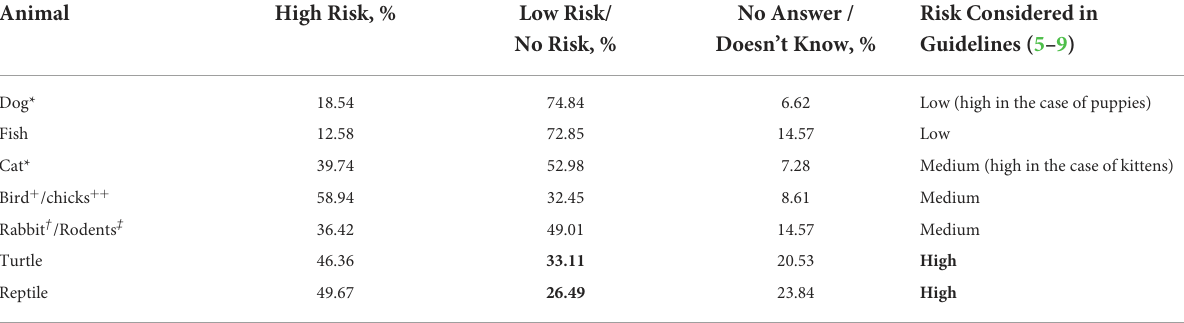
TABLE 2 The risks imposed by pet ownership perceived by the 151